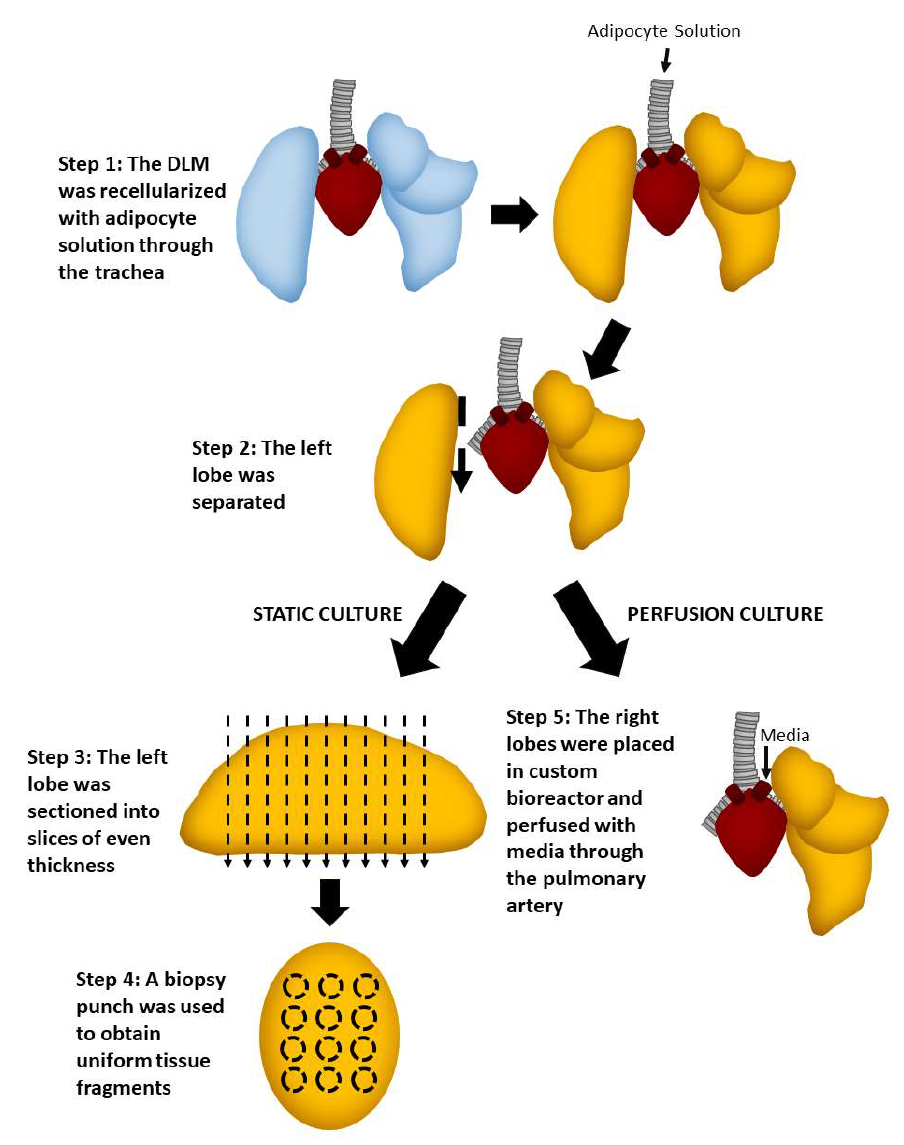
Figure 4 . Schematic showing how the lobes were processed to investigate static versus perfusion culture.